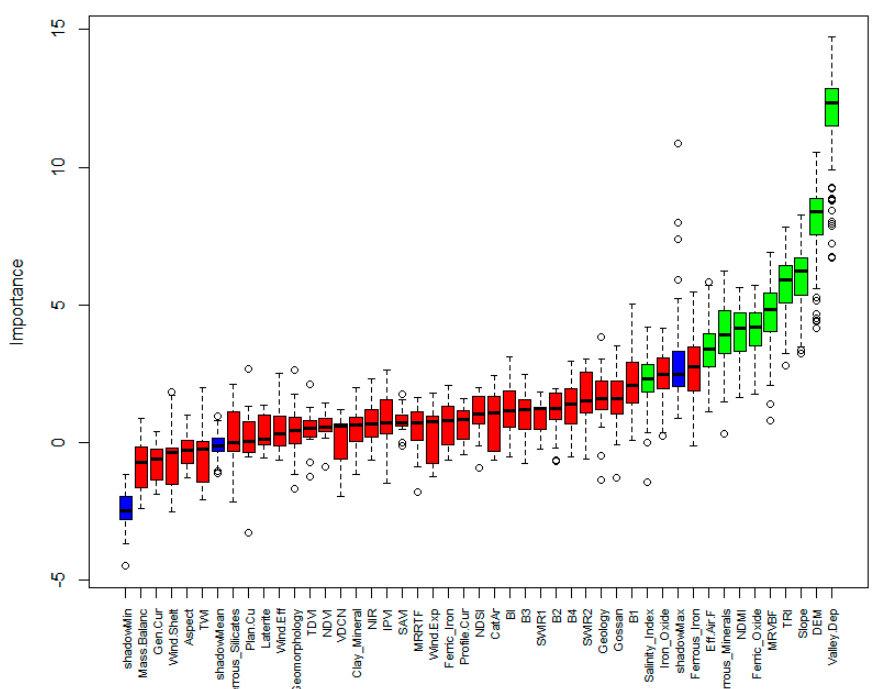
Figure 4. Brouta importance results for CEC in the study area in the west of Iran (Green and red box plots represent Z scores of confirmed and rejected attributes, respectively; blue box plots correspond to tentative attributes).